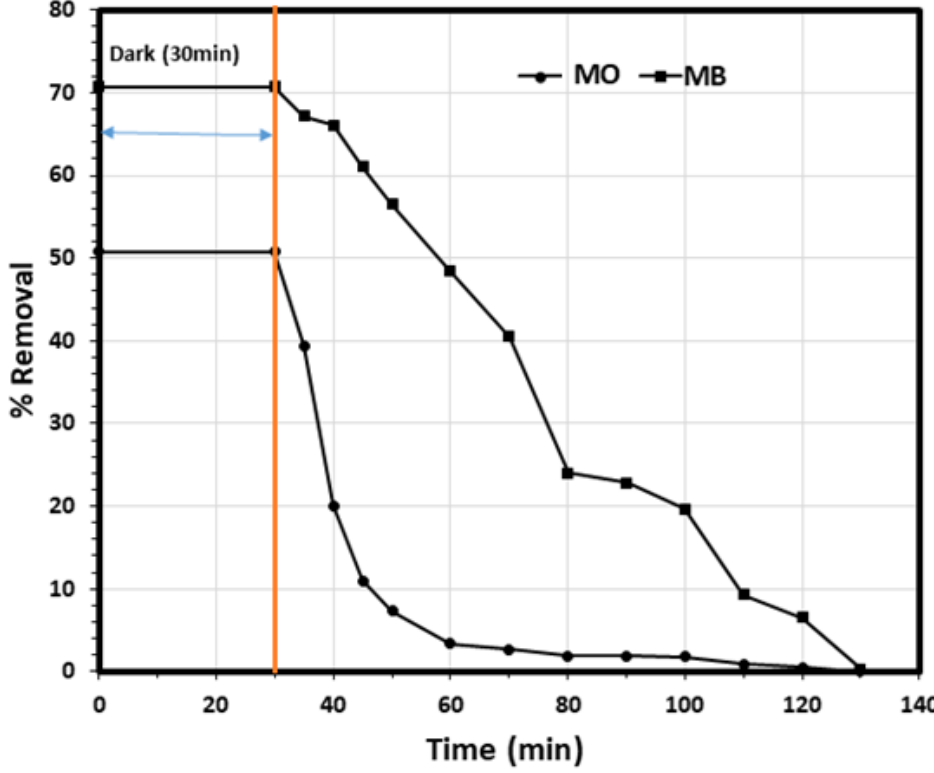
Figure 8. Removal efficiency of a model mixture solution containing MO and MB over BMW ZnO NPs. (Experimental conditions: 20.0 mL solution, pH 6, BMW ZnO NPs mass 15.0 mg, 298 K and [MO] 5.0 mg/L, [MB] 5.0 mg/L).